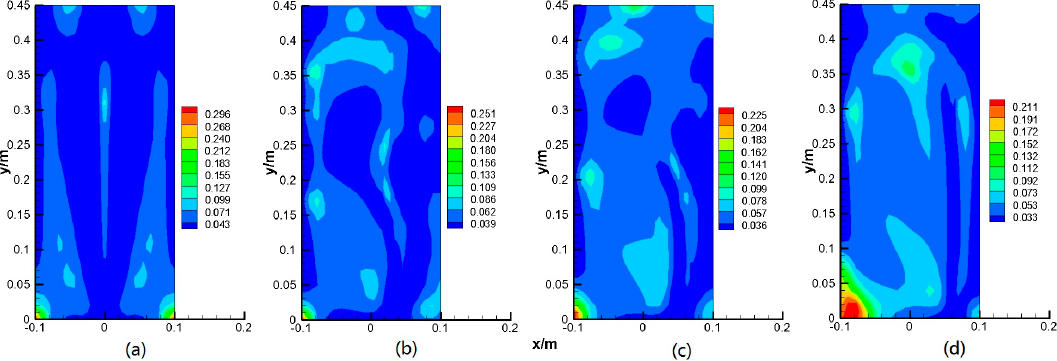
Figure 11. Dynamic viscosity distribution of non-Newtonian liquid at z = 0 m in the bubble column: ( a ) case 5 (NON-0), ( b ) case 6 (NON-0.025), ( c ) case 7 (NON-0.045), and ( d ) case 8 (NON-0.06).